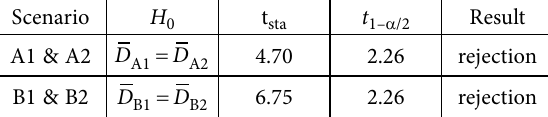
Table 3. t -test results of the four scenarios